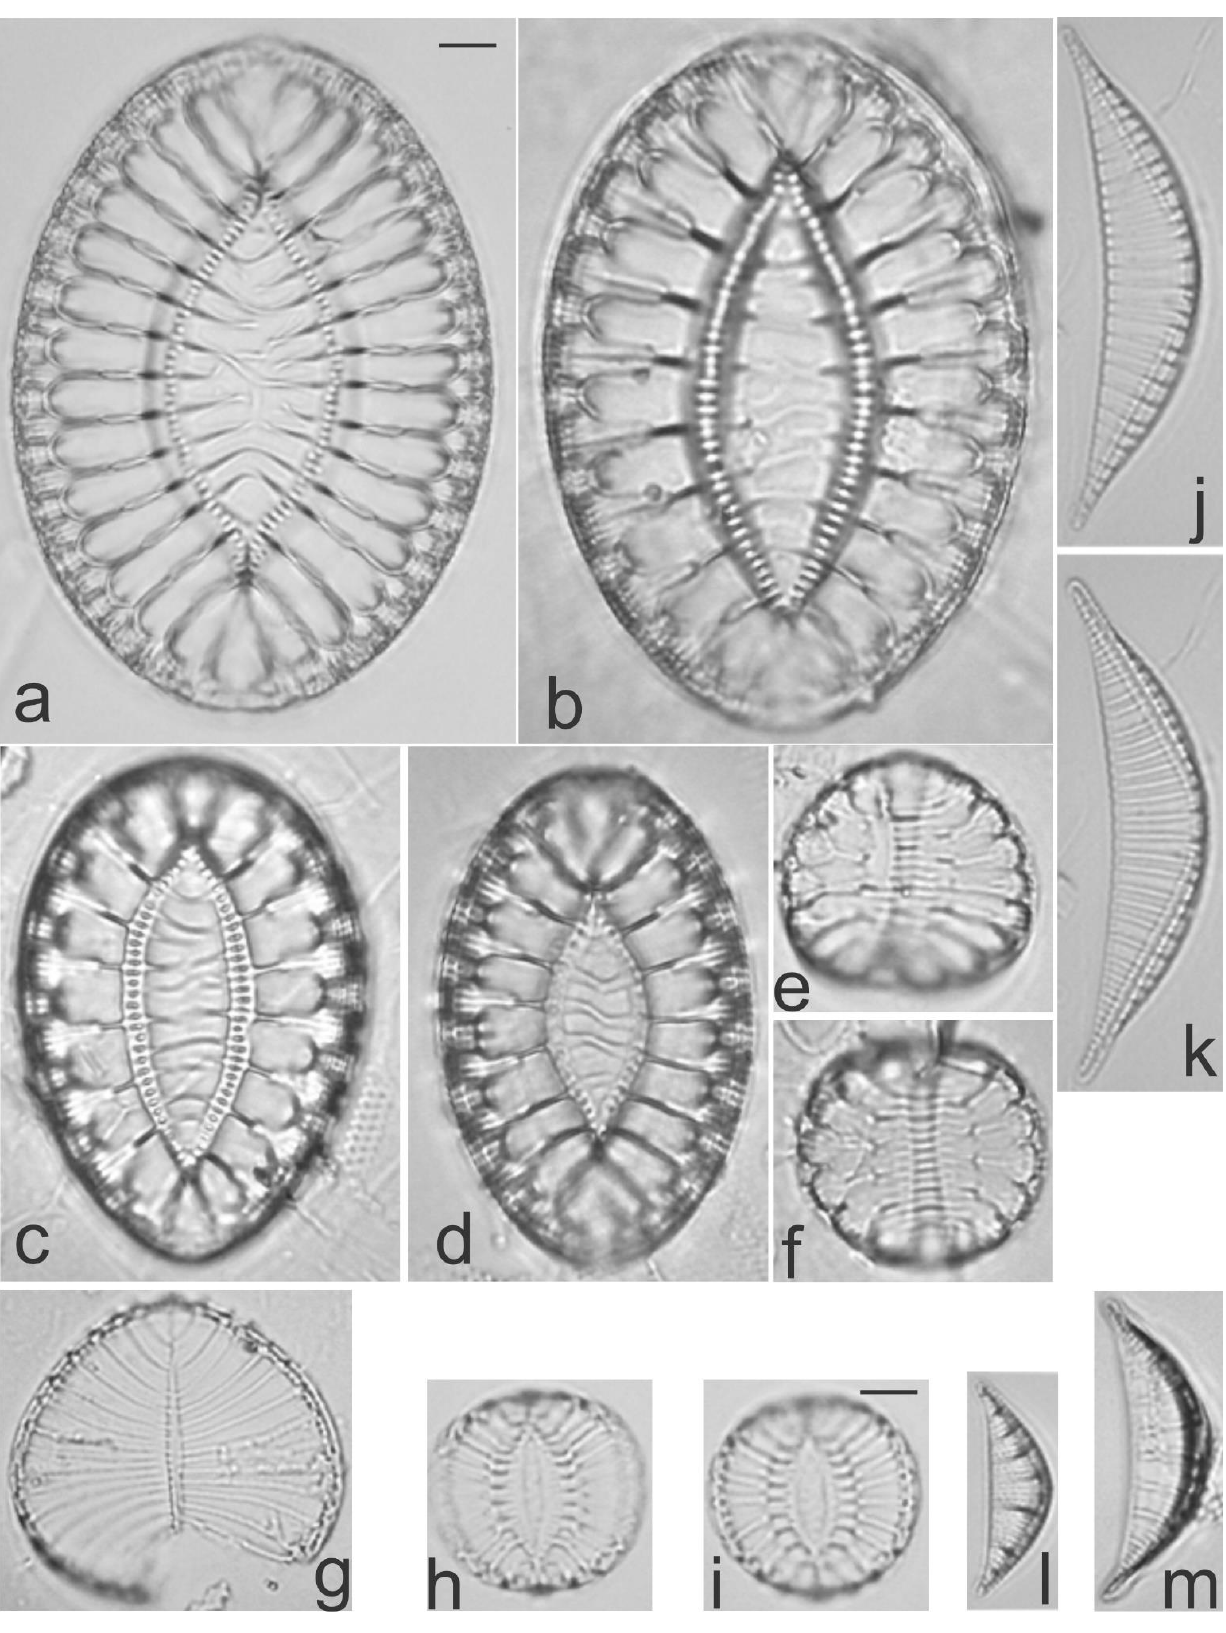
Figure 34. ( a – d ) Campylodiscus neofastuosus ; ( e , f ) C. thuretii ; ( g ) C. ralfsii ; ( h , i ) Campylodiscus sp. 1; ( j , k ) Epithemia guettingeri ; ( l ) Rhopalodia gibberula var. producta ; ( m ) Epithemia pacifica . Scale bar = 5 μm.